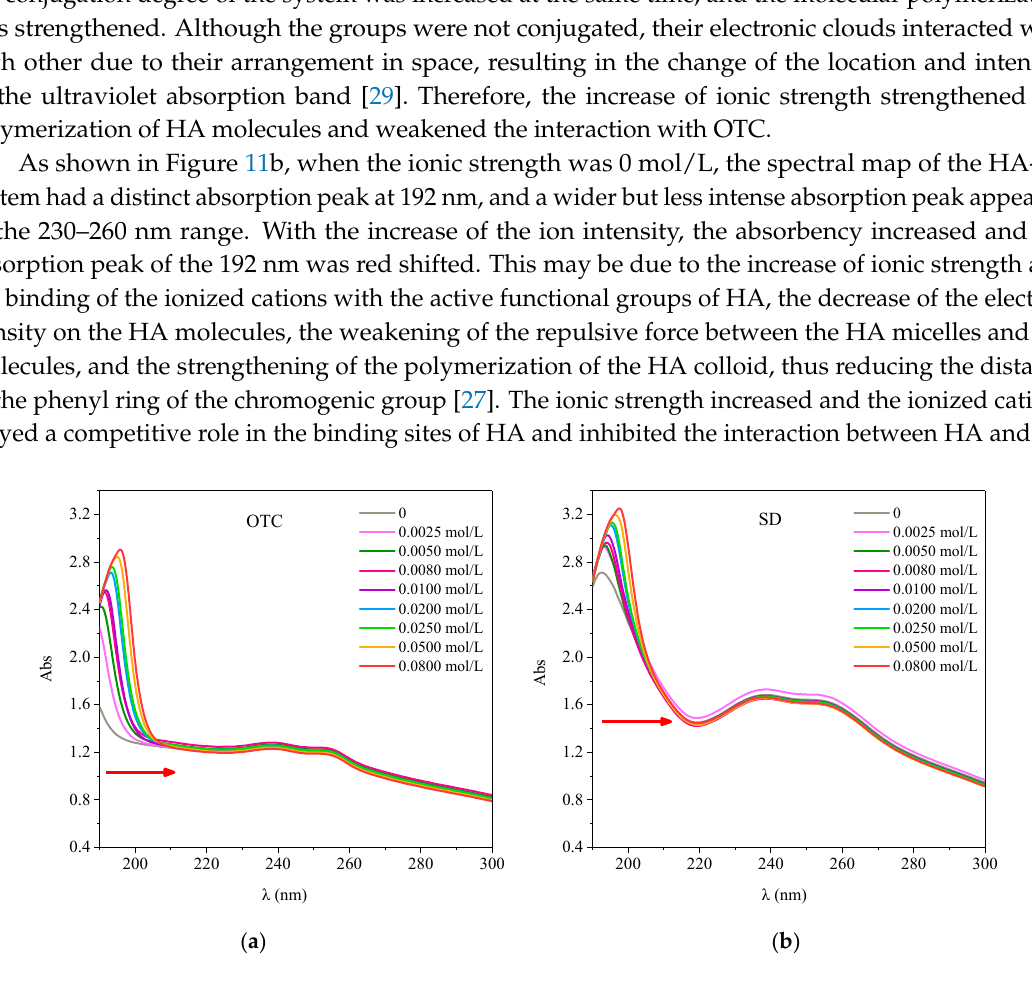
Figure 11. The interactions of OTC and SD with HA under different ionic strength. ( a ) OTC; ( b ) SD.